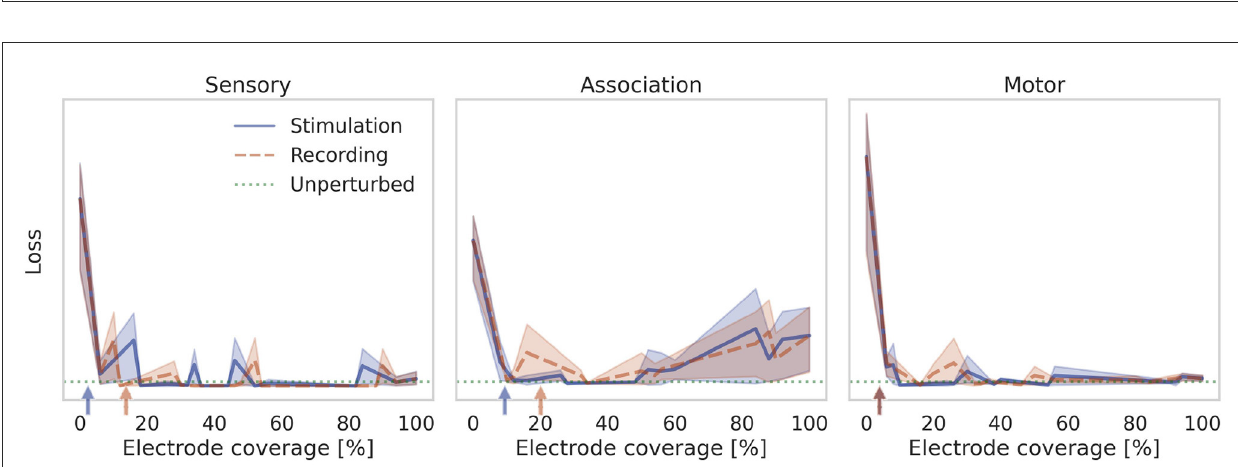
FIGURE8 Effect of reducing controllability and observability. The loss is shown when the prosthesis can record from and stimulate only a fraction of neurons in the neural system. The prosthesis restores the performance of the unperturbed neural system when about 10% of the neurons are accessible. This number approximately matches the lower bound estimated from the controllability and observability Gramians (indicated by